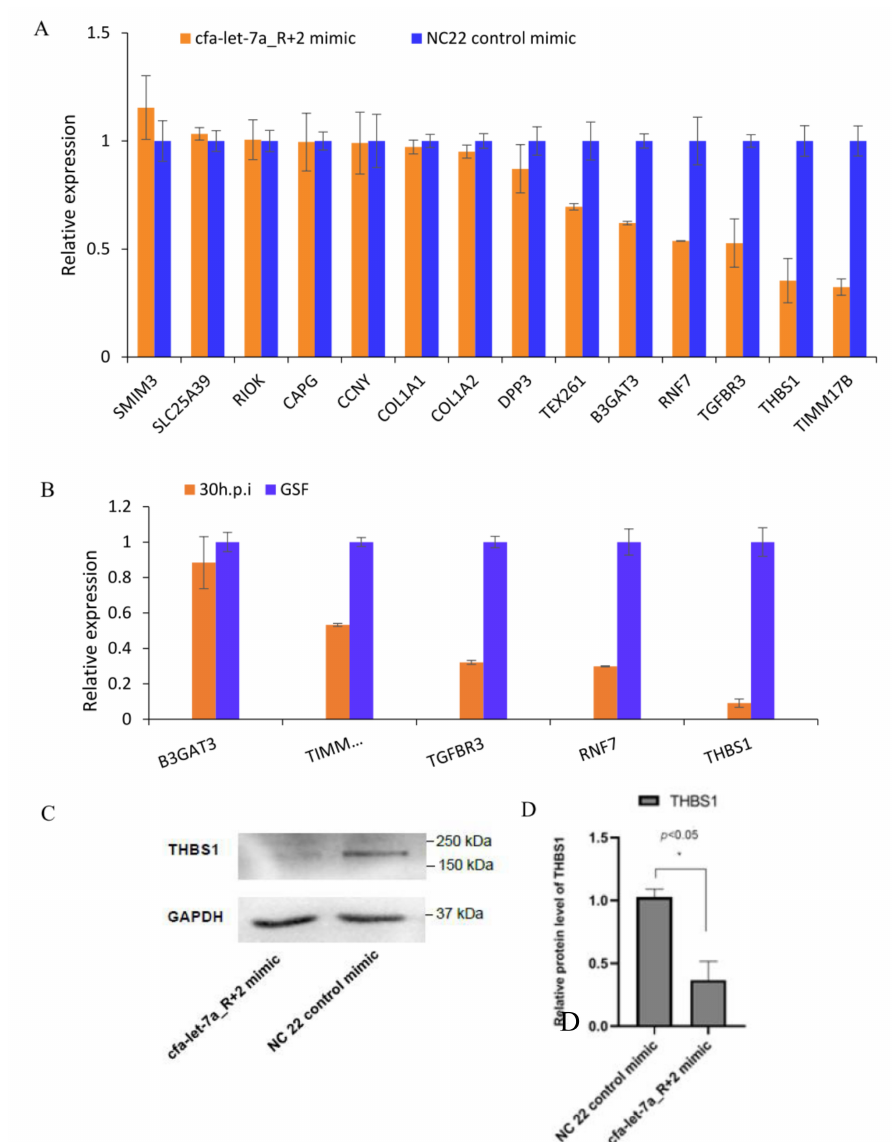
Figure 9. cfa-let-7a_R + 2 target prediction and validation. ( A ) RT-qPCR validation of cfa-let-7a_R + 2 targets after Table S7. a_R + 2 targets in RNA-seq. ( B ) RT-qPCR validation of cfa-let-7a_R + 2 targets in RNA-seq. ( C ) WB detection of THBS1 protein expression after transfecting miRNA mimics. ( D ) Gray analysis of THBS1 protein expression. P < 0.05 means significant di ff